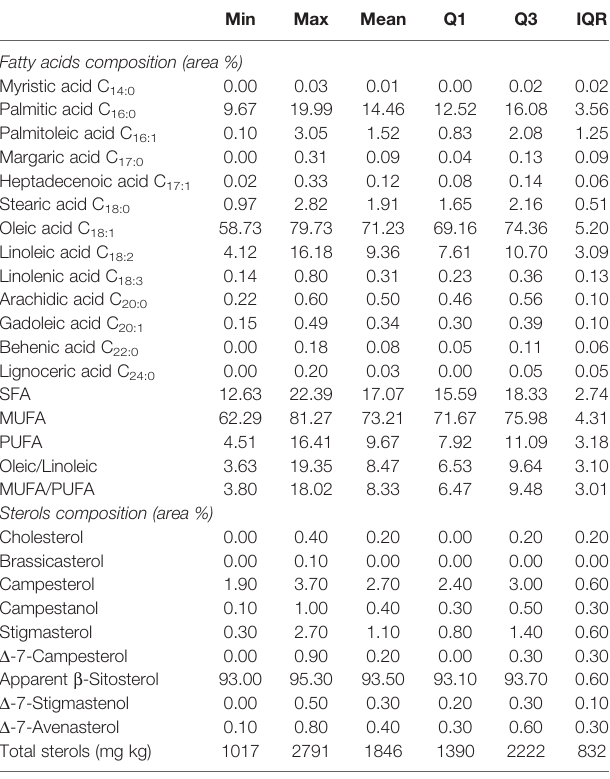
TABLE 5 | Descriptive statistics of the purity characteristics of the monovarietal oils obtained from 34 minor olive Apulian accessions. Min Max Mean Q1 Q3